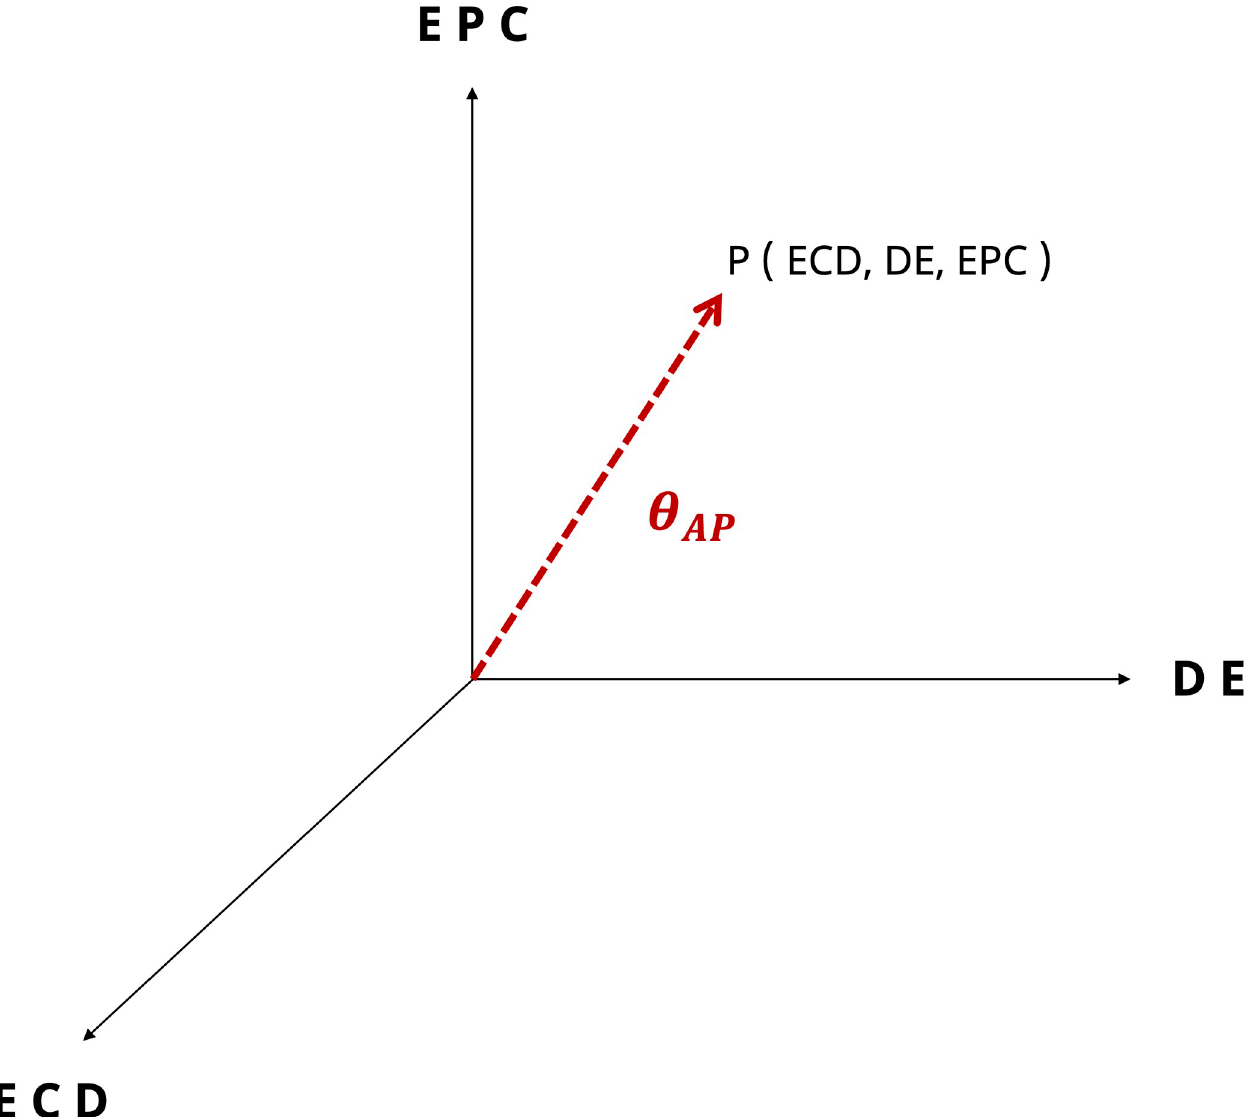
Fig 5. Description of θ represented as a single value through a three-dimensional AP